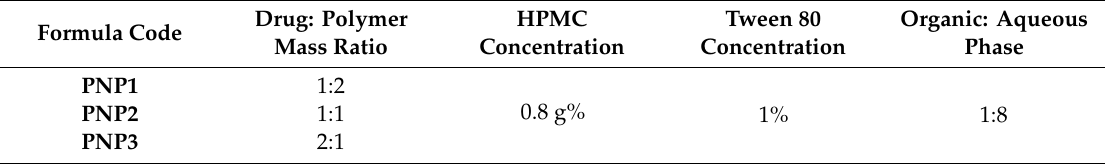
Table 1. The composition of prepared doxycycline polymeric nanoparticles (DOXY-PNPs).